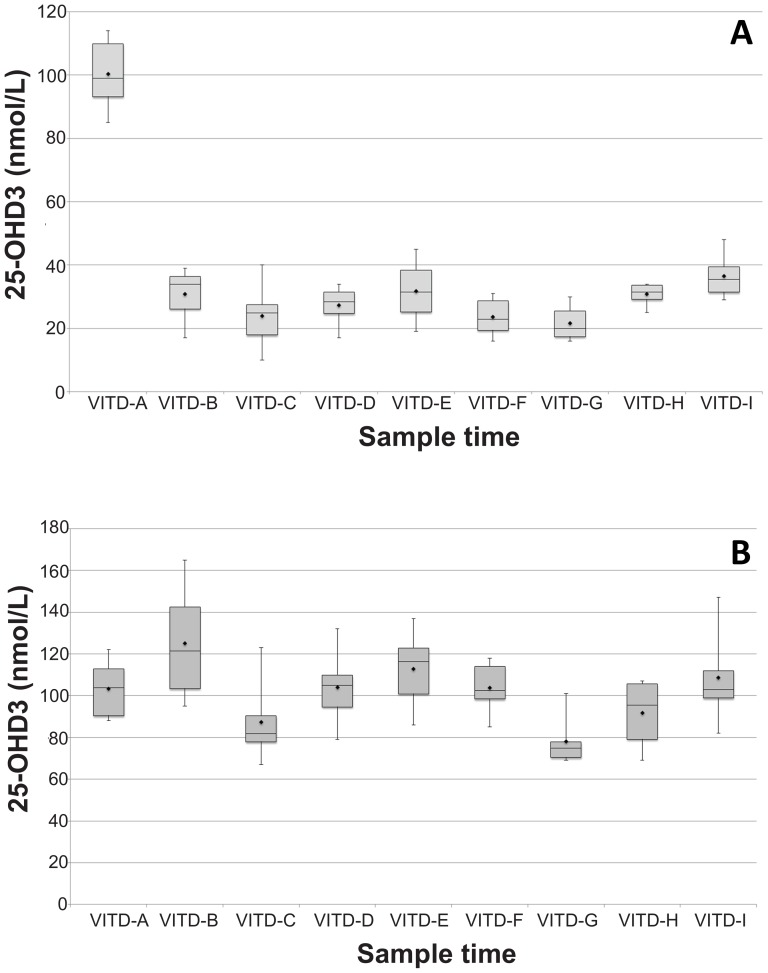
A) Guinea pig serum 25-OHD3 levels with no UVB supplementation.B) Guinea pig serum 25-OHD3 levels for UVB supplemented group. (Time = sample number).